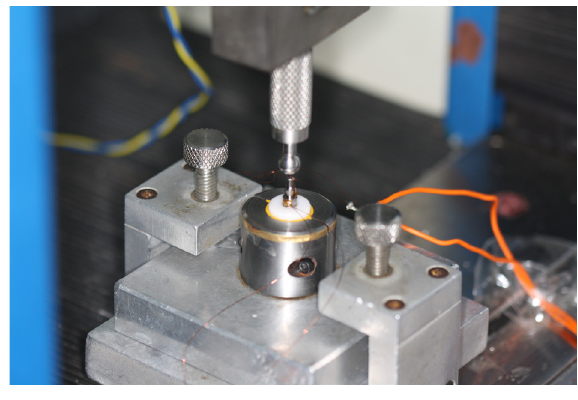
Figure 2. Strain gauge fixation. Figure 3. Axial loading was